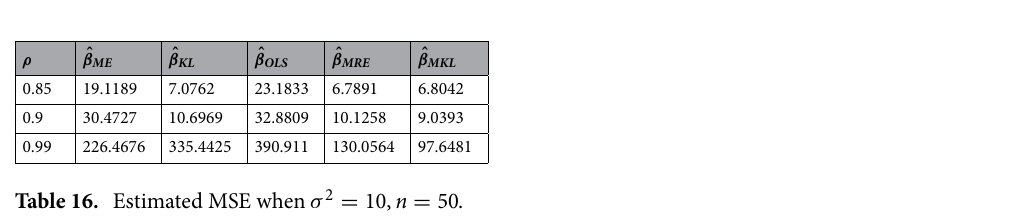
Table 16. Estimated MSE when σ